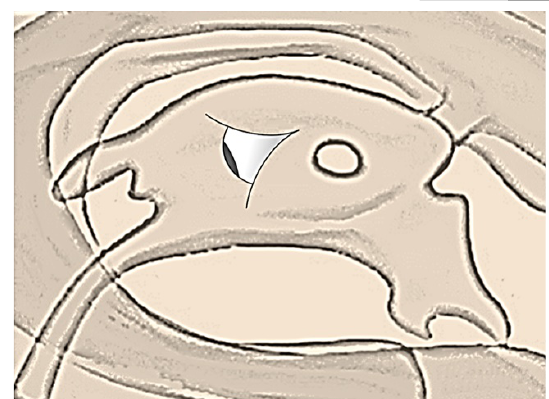
Fig. 18. Direction of the endoscopic viewing angle for the posterior segment of the third ventricle.